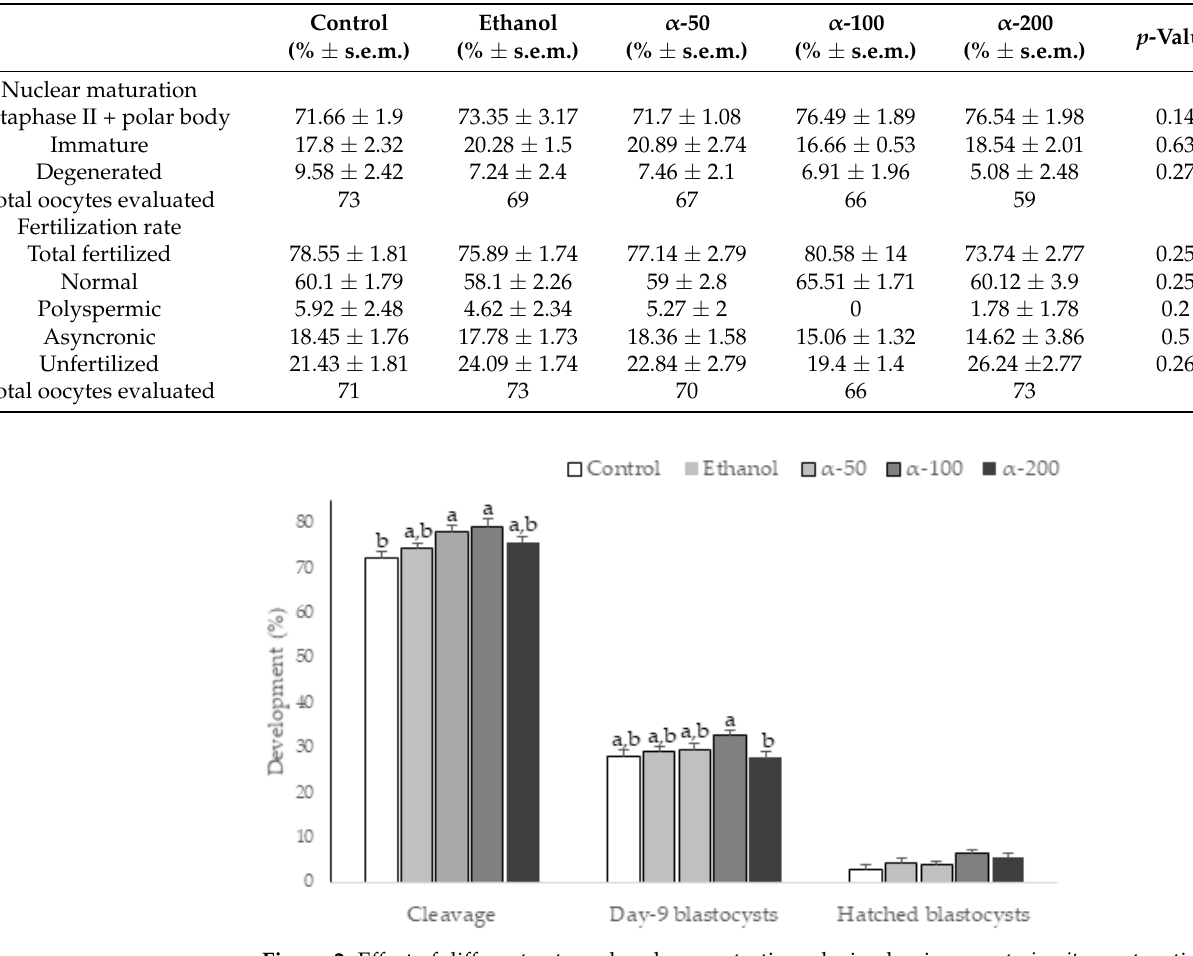
Figure 3. Effect of different α -tocopherol concentrations during bovine oocyte in vitro maturation on ( A ) total cell number, and ( B ) blastocyst apoptotic index. ( C ) Representative digital images of Hoechst and TUNEL staining of day 9 blastocysts derived from bovine oocytes collected during summer and in vitro matured in absence (control and 0.05% ethanol) or presence of α -tocopherol at 50 ( α -50), 100 ( α -100), 200 ( α -200) μ M, and positive and negative TUNEL assay controls. The white bar represents the 50 μ m mark. Different letters above each bar represent significant differences ( p < 0.05).